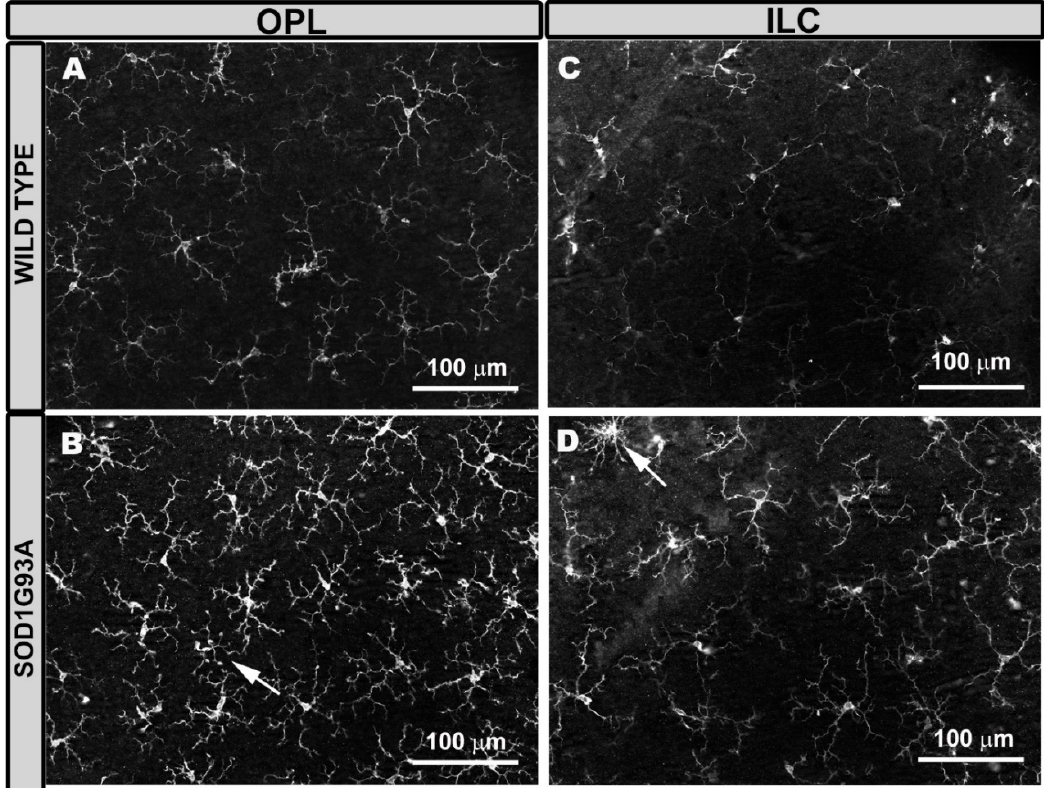
Figure 1. Microglial cells in the outer plexiform layer (OPL) and in the inner layer complex (ILC) constituted by the inner plexiform layer and nerve fiber layer–ganglion cell layer. Retinal whole-mount was labeled with anti-Iba-1. In aged-matched wild type mice, the microglial cells of the OPL ( A ) and the ILC ( C ) showed a ramified morphology, featuring primary processes from which they derive secondary processes, and constituted a regular plexus of tiled cells along the retina. ILC microglia processes were thinner than those of OPL. In SOD1G93A mice, the microglia of the OPL ( B ) and the ILC ( D ) showed thickening of the cell body and processes, giving the cell a more robust and larger appearance. Some microglial cells showed a retraction of these processes (arrow). Number of retinas used in the experiment, WT: n = 6; and SOD1G93A: n =